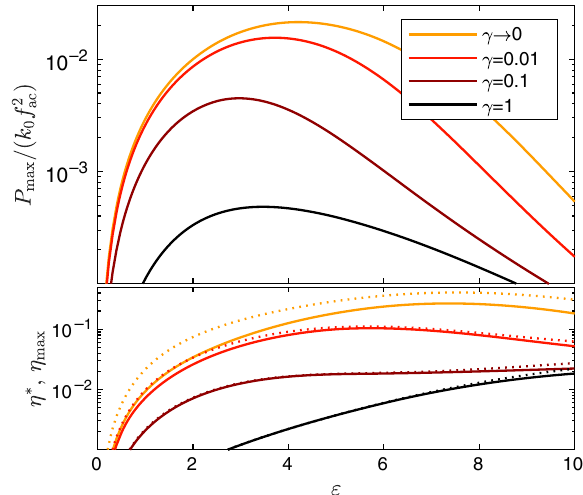
FIG. 3. Numerical evaluation of the engine performance in the lattice model with L ¼ 10 sites. Top: The maximum extractable power as a function of the dimensionless interaction strength ε . The parameters of the active particle, k 0 ¼ 1 , f selected values of γ are kept fixed, while the extracted power P is optimized with respect to w 0 and f ex tumbling rate γ → 0 (orange) is evaluated using the effective potential (A1). Bottom: The active efficiency η (cid:4) at maximum power (solid lines) and the maximal active efficiency η lines) optimized again with respect to w 0 and f